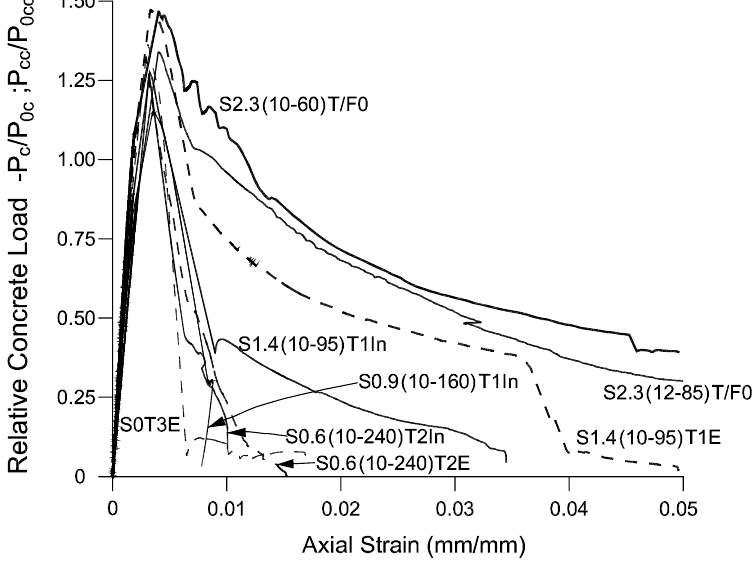
Figure 7. Normalized stress–strain curves of TRC-TSR confined specimens.